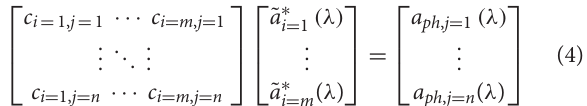
TABLE 1 | Diagnostic pigments used in the present study as biomarkers for phytoplankton functional types (Barlow et al., 1999; Vidussi et al., 2001; Wright and Jeffrey, 2006